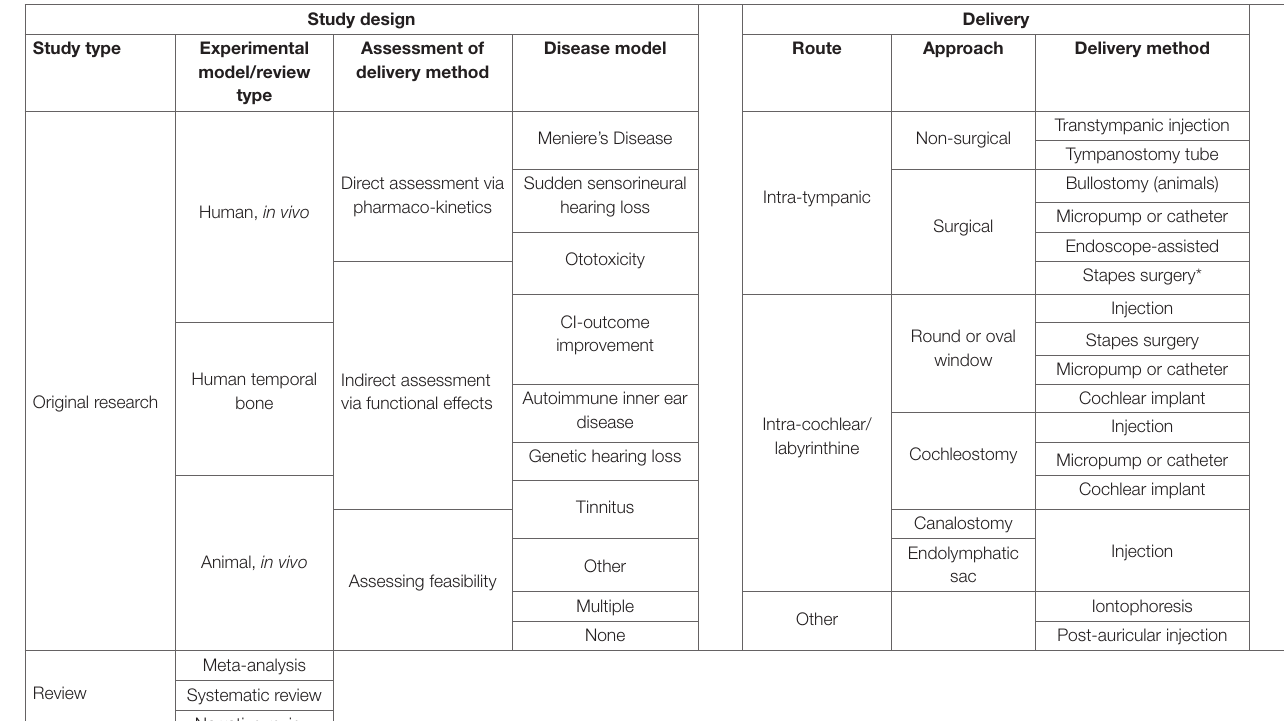
TABLE 2 | Categorization of extracted data in local therapeutic delivery to the inner